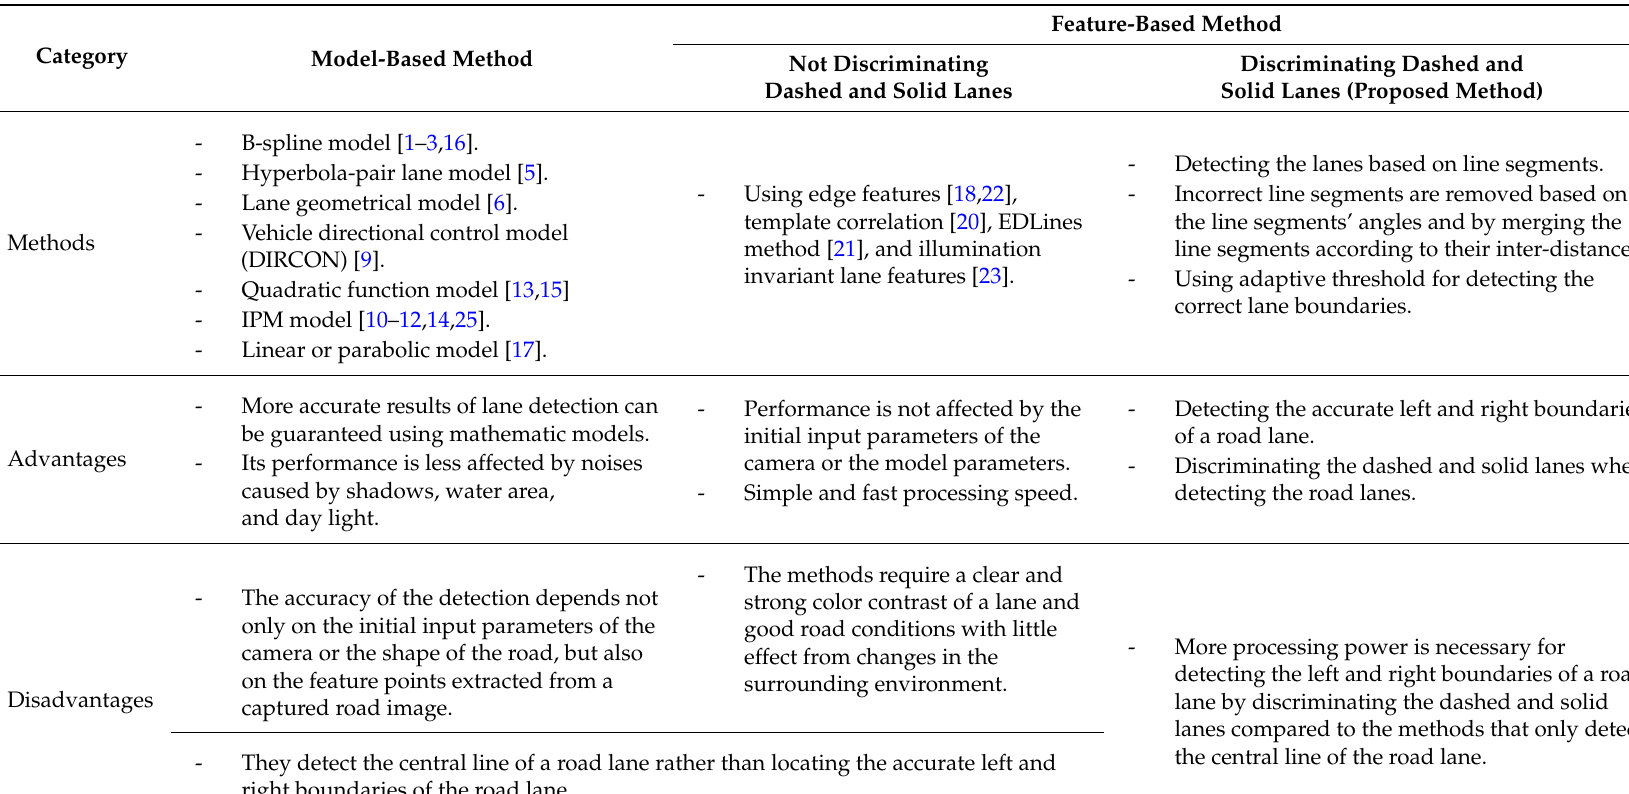
Table 1. Comparison of previous and the proposed